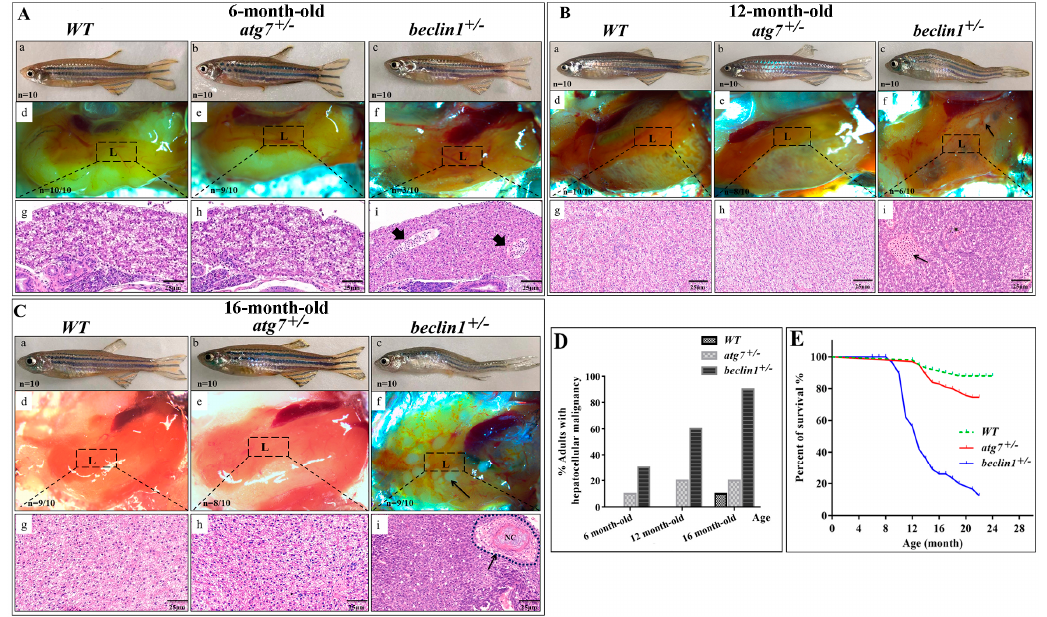
Figure 2. Beclin1 heterozygosity leads to liver disorders in adult males. ( A ) ( a – c ) Representative pictures of 6-month-old male zebrafish. ( d – f ) The liver phenotypes in dissected males. ( g – i ) hematoxylin and eosin (H&E) histological staining of zebrafish livers and the beginning of bile ductus sequestration (arrowheads). ( B ) ( a – c ) Representative pictures of 12-month-old male zebrafish. beclin1 +/ − has enlarged the belly and curved the body. ( d – f ) The liver phenotypes in dissected males. Hepatic ulcers (black arrow) were observed in the beclin1 +/ − males. ( g – i ) H&E histological assay showing the tumor cells cords and bile sequestrations (black arrow) in beclin1 +/ − . ( C ) ( a – c ) Representative pictures of 16-month-old male zebrafish. ( d – f ) The liver phenotypes in dissected males. beclin1 +/ − liver had a hemorrhagic and necrotic appearance distributed on the inferior surface of the liver (black arrow). ( g – i ) H&E histological assay showing the development of confocal necrosis at 16-month-old male beclin1 +/ − (black arrow). NC: Necrosis. ( D ) Prevalence of microscopic hepatocellular malignancy. n = 10 for each experimental group. ( E ) Meire Kaplan graphs depicting the survival rate of the three reared strains. n = 50 for each experimental group. Beclin1 +/ − exhibited lower survival rate than WT at 12- and 16-month-old respectively ( p < 0.0001). L: liver, the dotted frame represents liver histology in the underlined pictures.